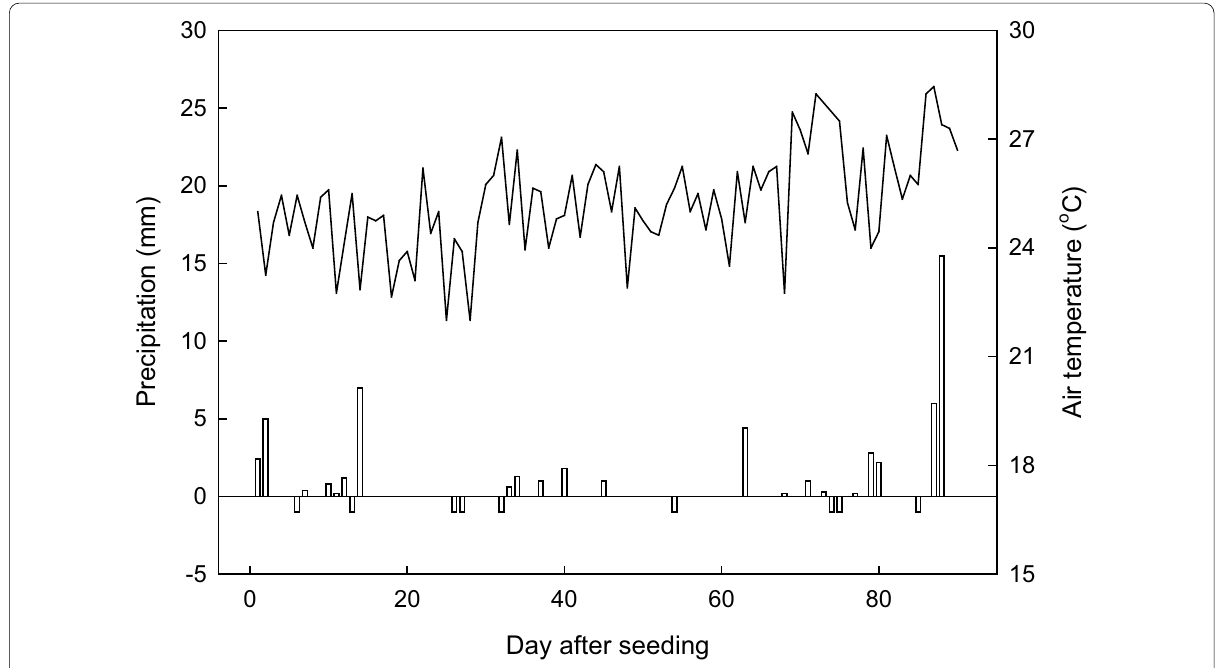
Fig. 2 Changes in precipitation and air temperature during sweet corn cultivation